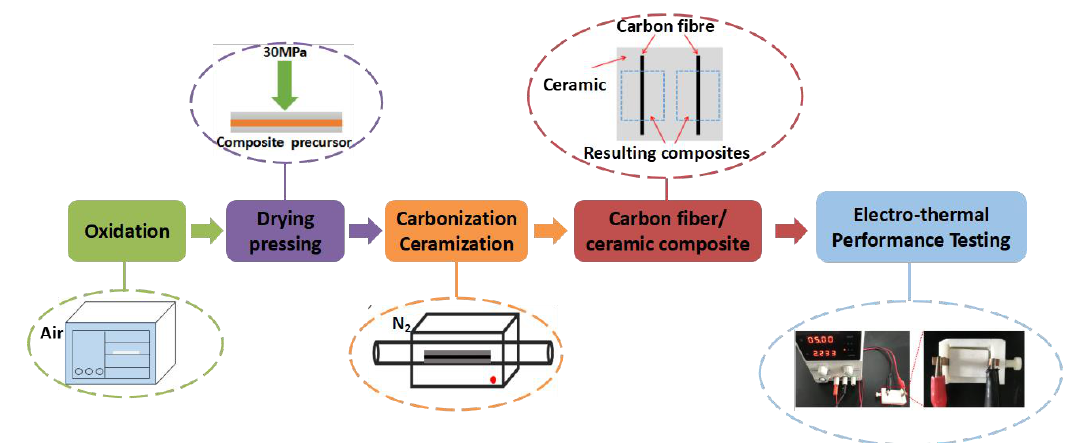
Figure 1. Scheme of the fabrication process of the ceramic composite with carbon fiber.